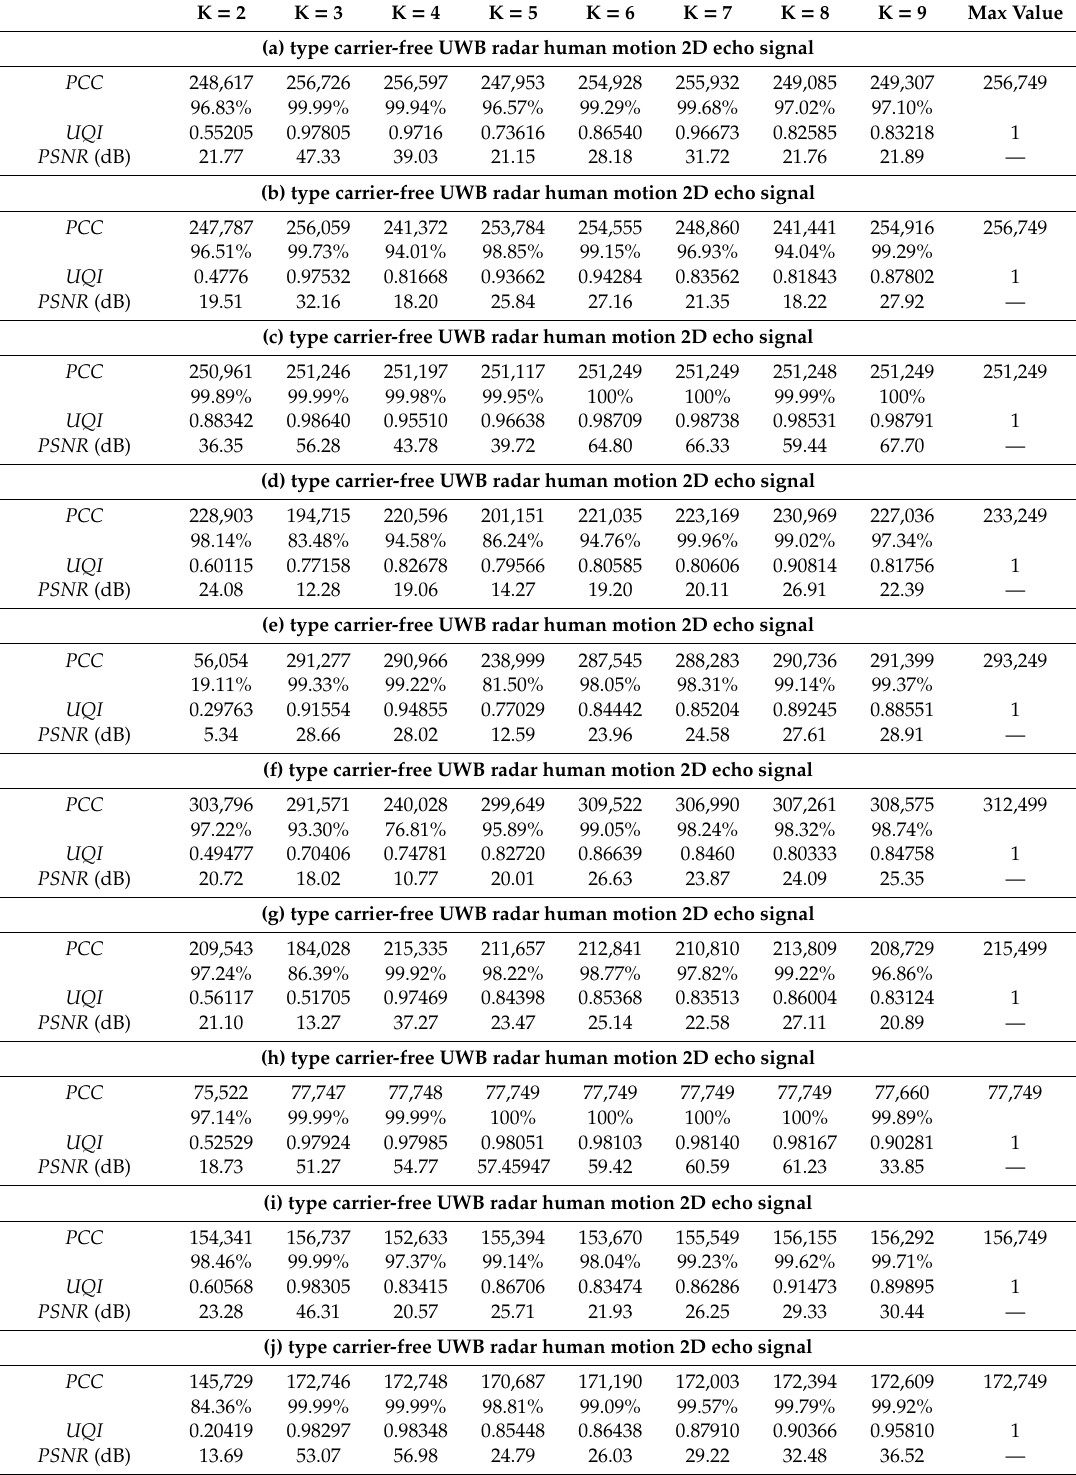
Table 5. Three indicators of PCC , UQI , and PSNR for 2D echo signal reconstruction of ten di ff erent types of UWB radar with di ff erent decomposition layers in 2D-VMD